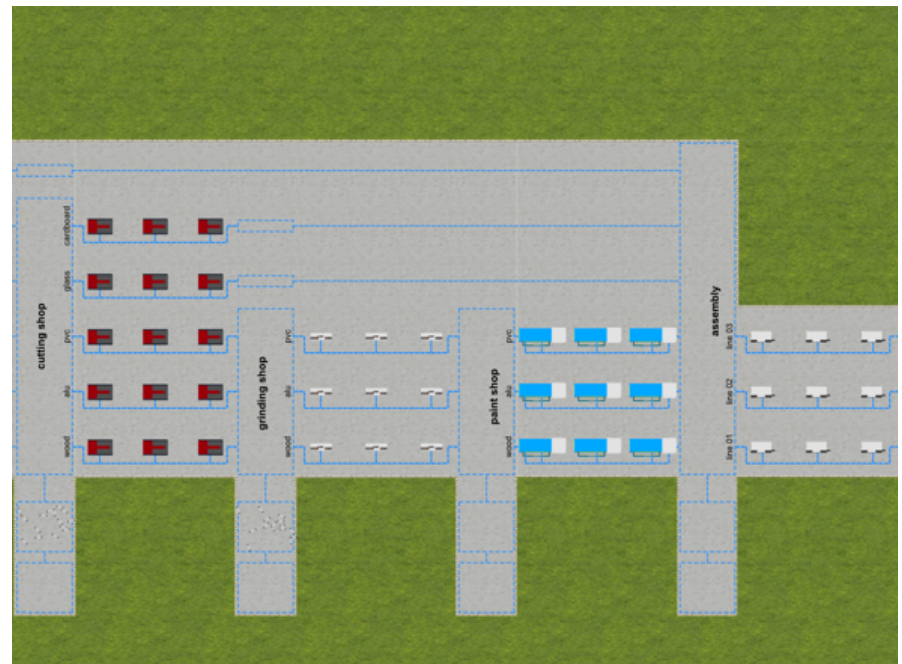
Figure 2. Shop floor simulation in Anylogic